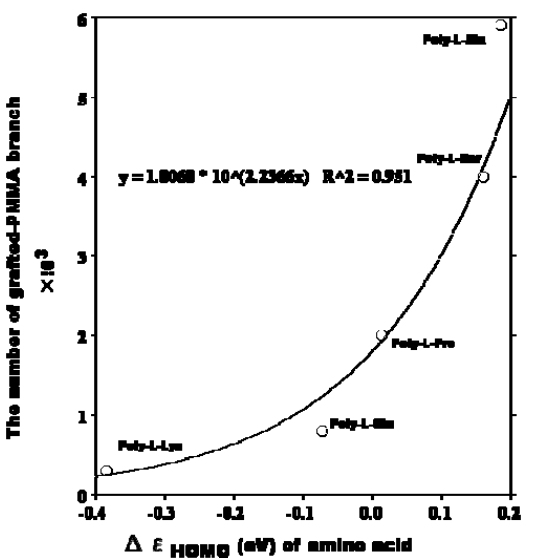
Figure 1. Relationship between the number of grafted-PMMA branches of poly-L-peptides and the Δε HOMO of the corresponding amino